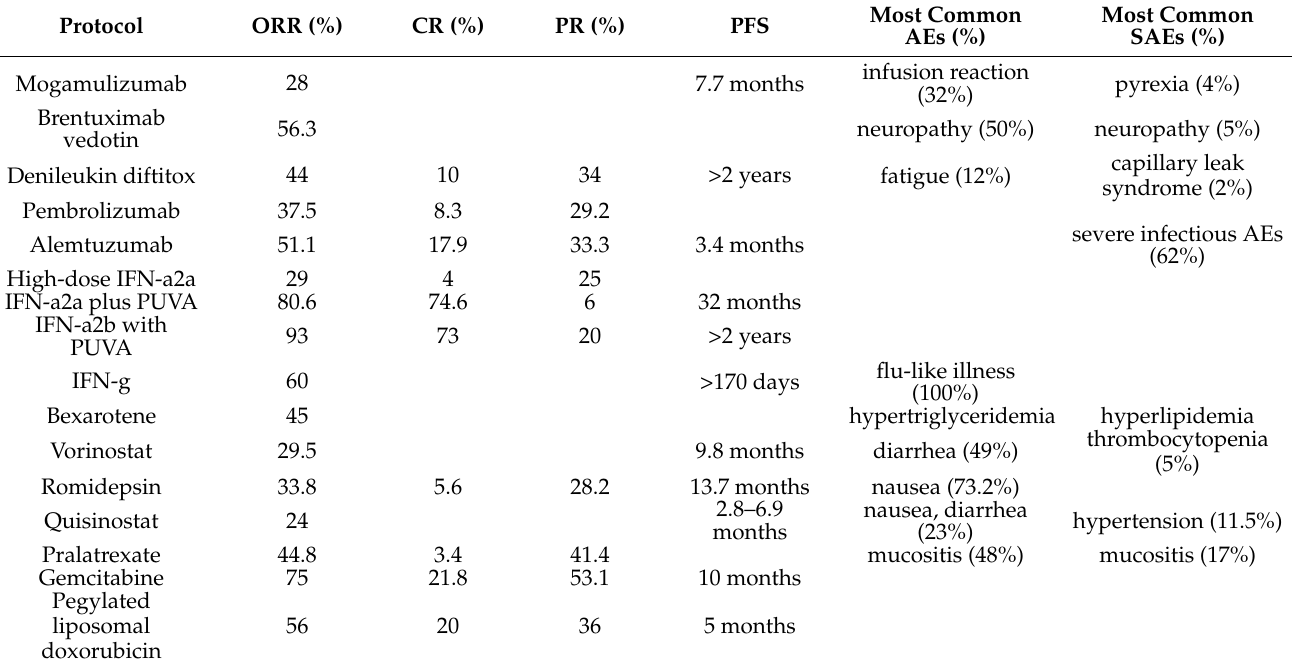
Table 2. The efficacy of systemic formulations for treatment of